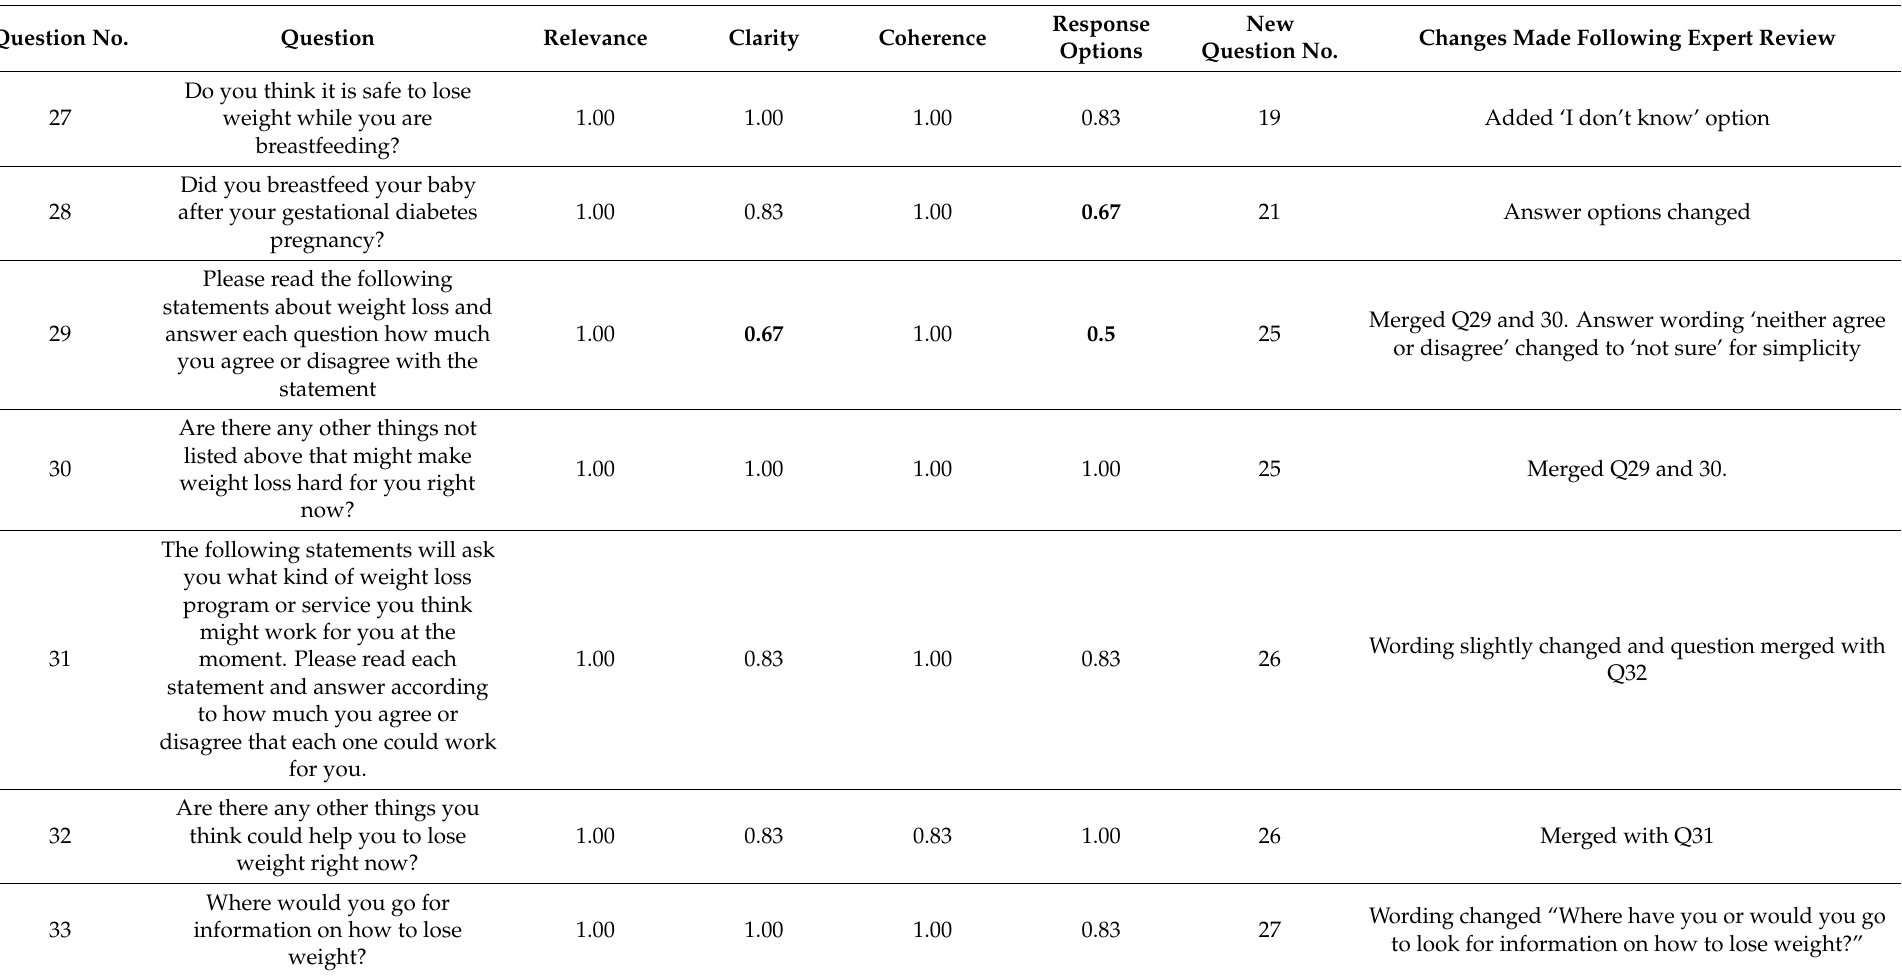
Version 1 of Survey: Items Constructed by the Research